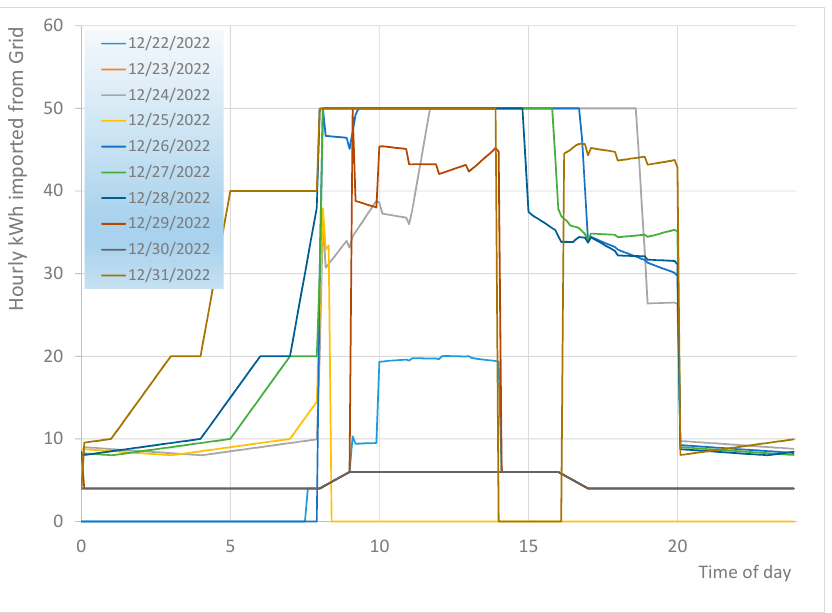
Figure 17. Hourly distribution of electricity dispatched from the GenSet for the last 10 days of De- cember.